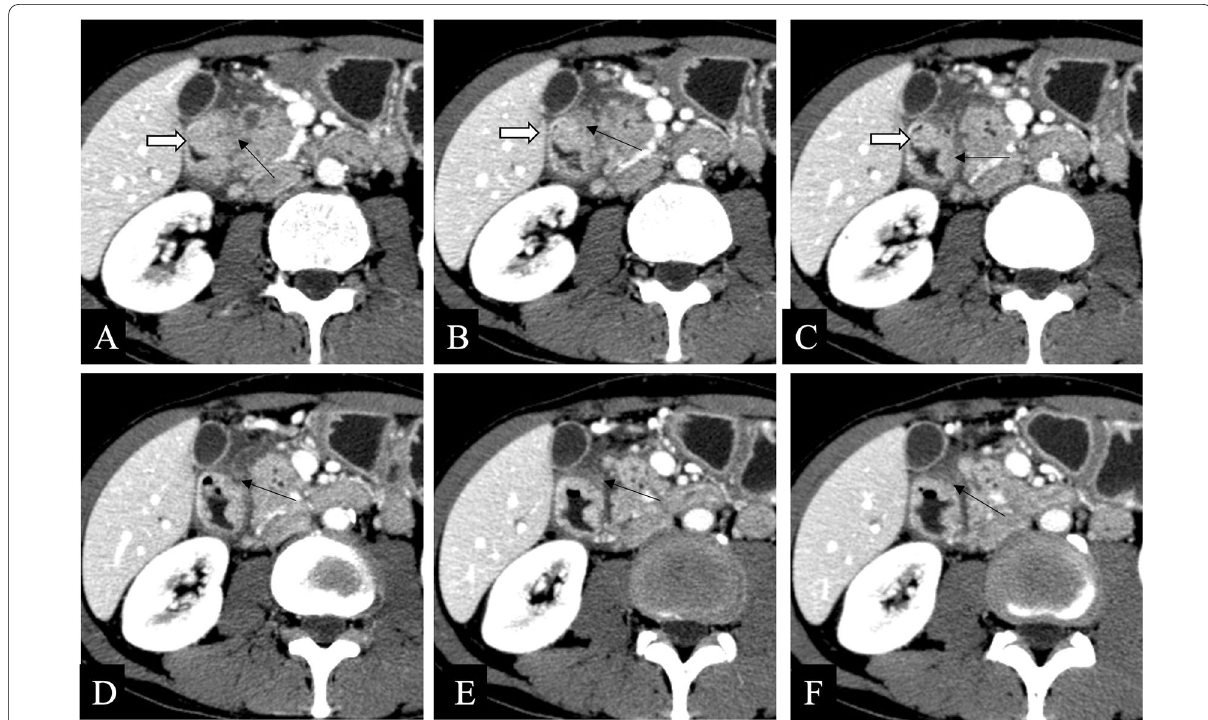
Fig. 3 Groove pancreatitis in a 44‑year‑old male. a–f Axial contrast‑enhanced CT images showed a sheetlike hypoattenuating mass (black arrows) in the pancreaticoduodenal groove and separated from the pancreatic head and the duodenum, with thickening of adjacent medial wall of the duodenum. a–c The final pathology demonstrated a 2.7 cm sized heterotopic pancreas in the duodenum (white